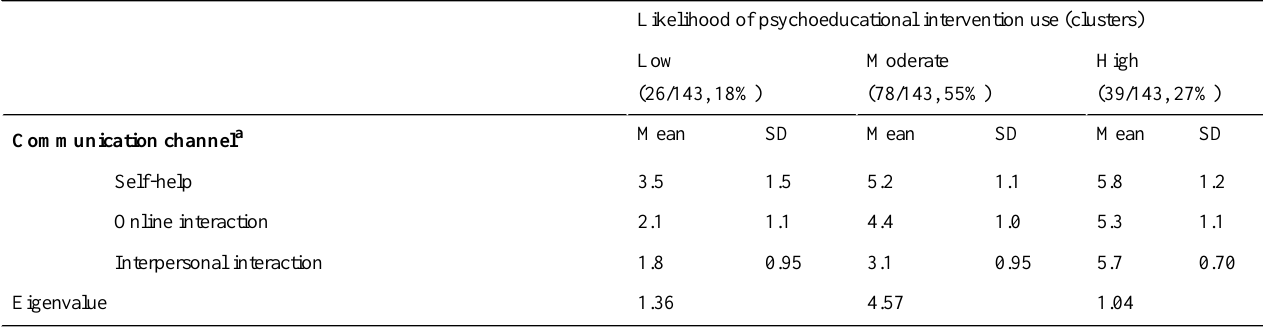
Table 3. Cluster analysis of partners’preferred communication channels